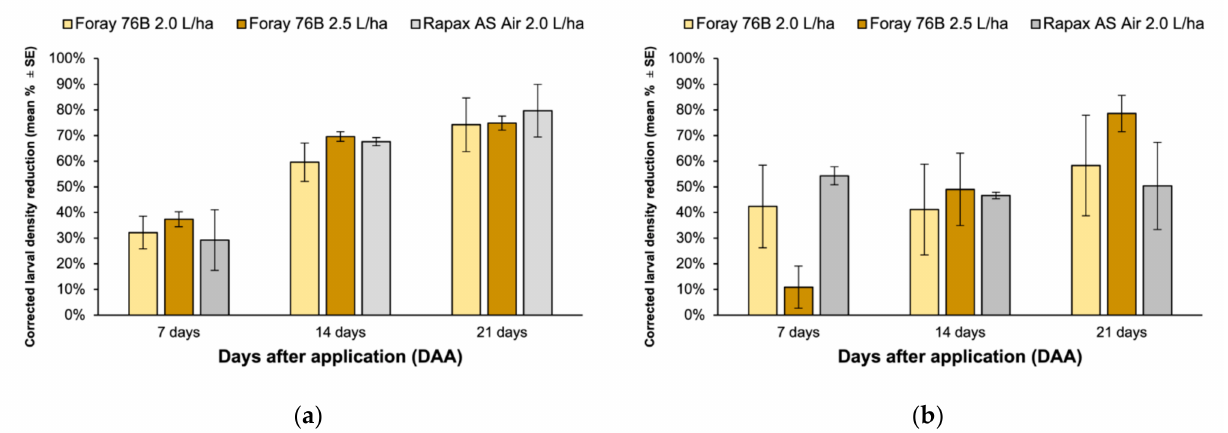
Figure 1. Percentage reduction of Lymantria dispar larval population caused by application of Foray 76B ® (2.0 L/ha and 2.5 L/ha) and Rapax AVIO ® 7, 14, and 21 days in ( a ) 2018 and ( b ) 2019 panel. Larval reductions were corrected with the Schneider–Orelli